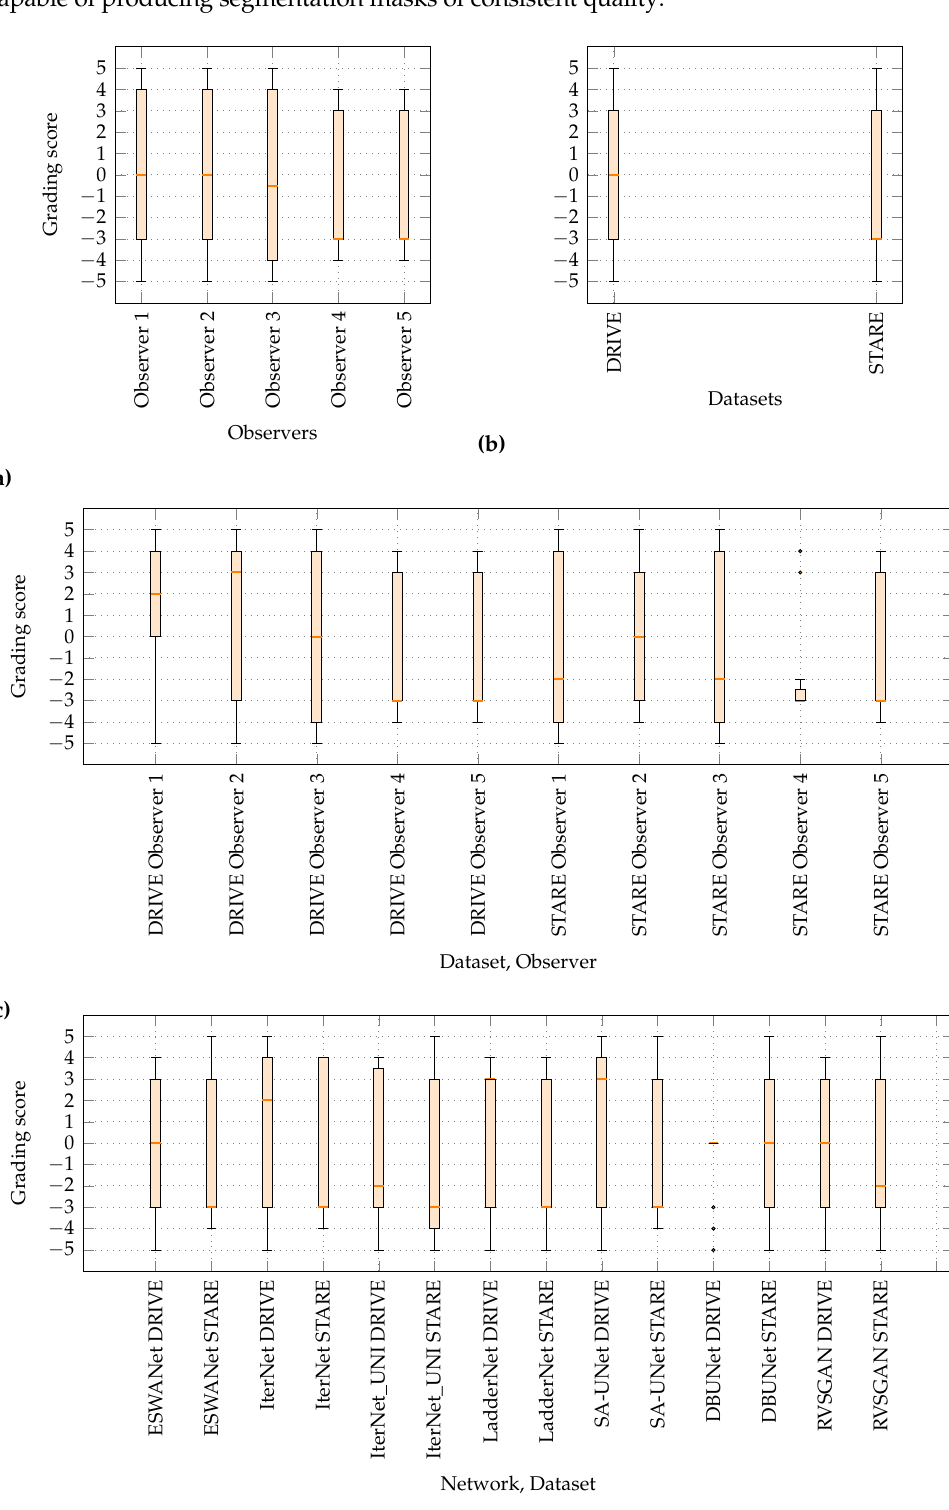
Figure 6. Grading score distributions grouped by ( a ) observers, ( b ) datasets, ( c ) datasets and ob- servers, and ( d ) networks and observers. The elementary results for UNet-generated segmentation masks were not included for the reasons discussed in Section